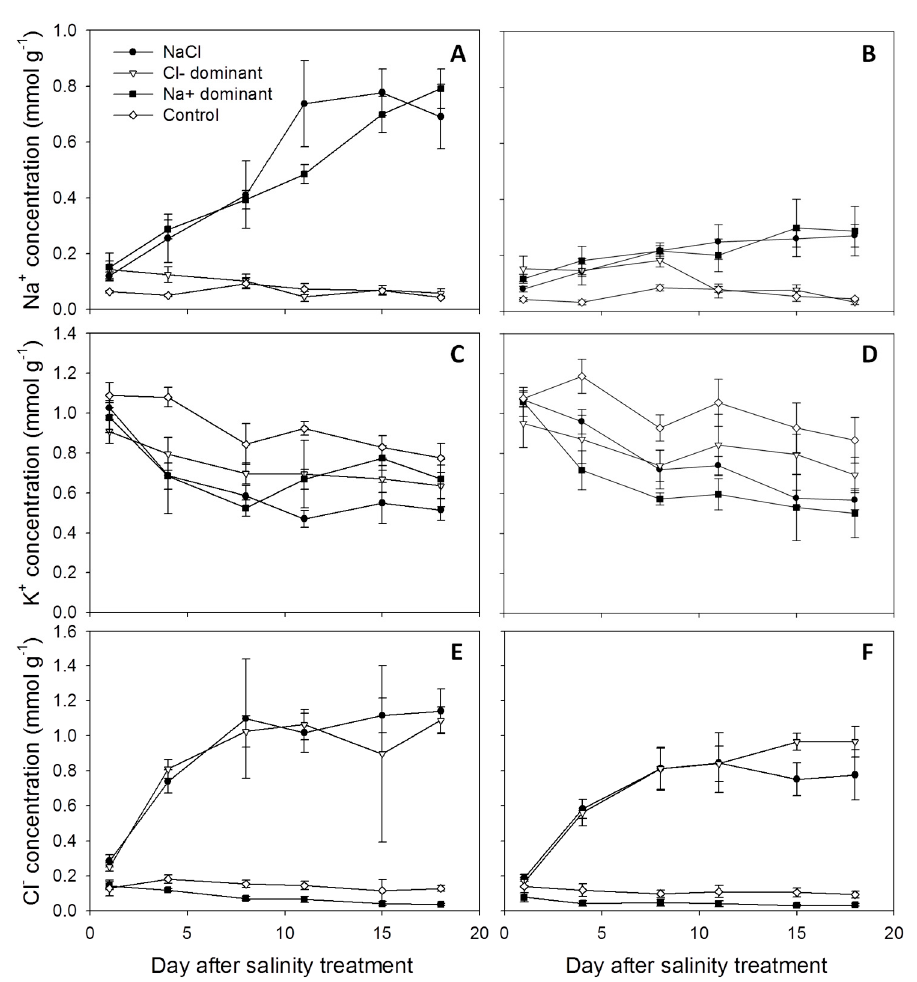
Figure 1. Concentrations of Na + ( A , B ), K + ( C , D ) and Cl − ( E , F ) in leaves of cucumber genotypes Aramon (A,C,E) and Line-759 (B,D,F) grown under different salt combinations. Samples were obtained from the second (1 and 4 DAS), third (8 and 11 DAS), and fourth (15 and 18 DAS) leaves. Values are means ± SD ( n = 5).